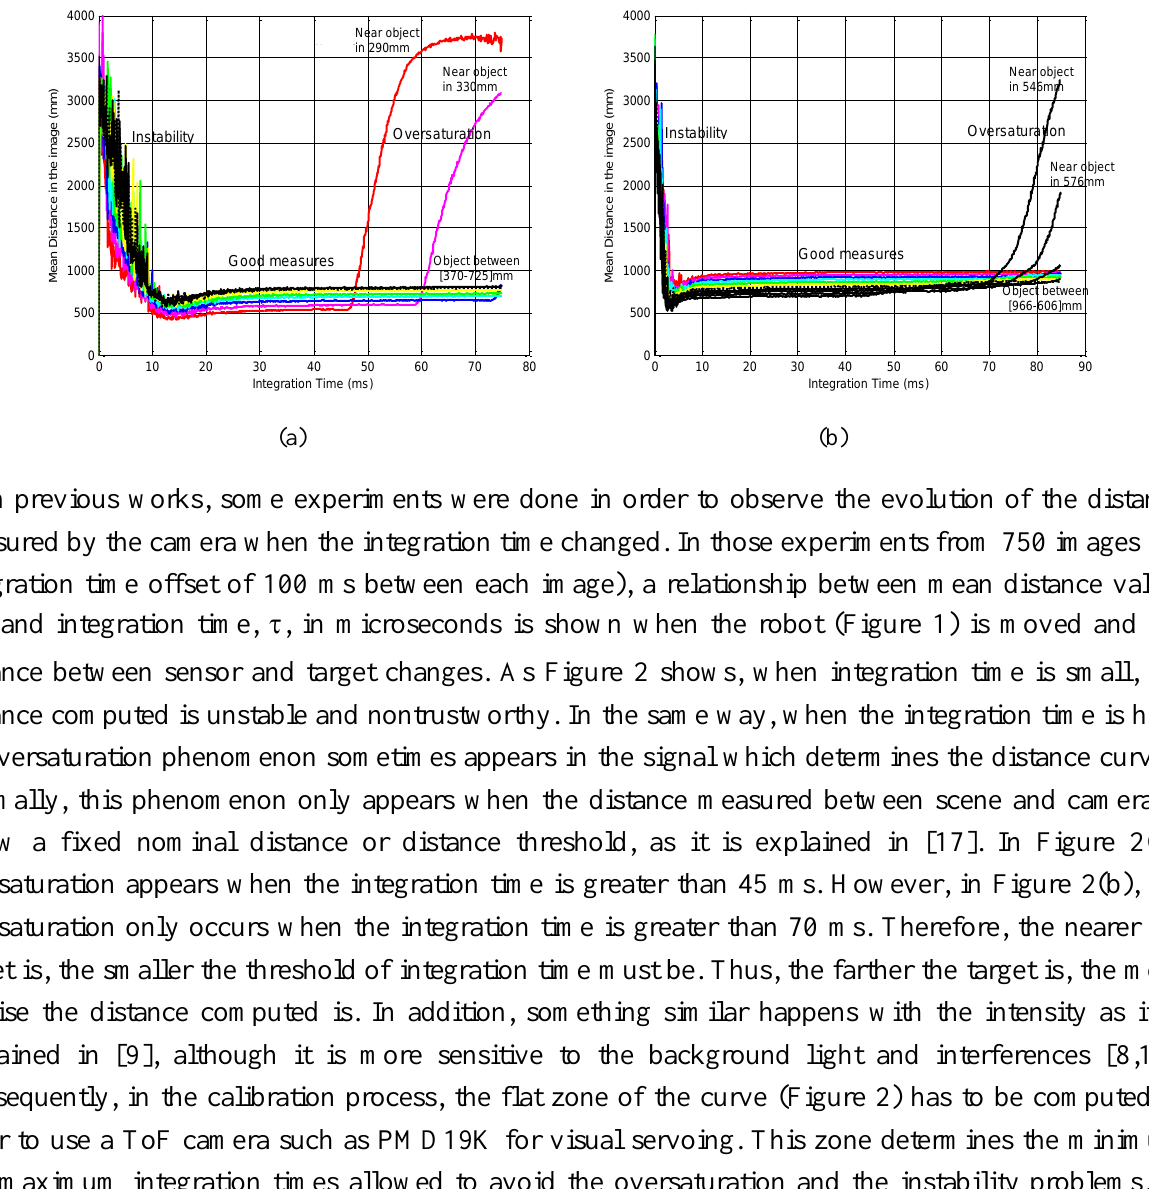
Figure 2. Evolution of the mean distance of the range image for two different scenes: (a) An object and the camera moved between 0.5 m and 1 m. (b) Four objects and the camera moved between 0.3 m and 0.8